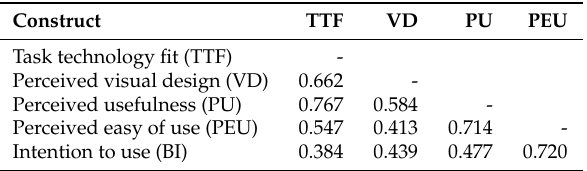
Table 7. Correlations of